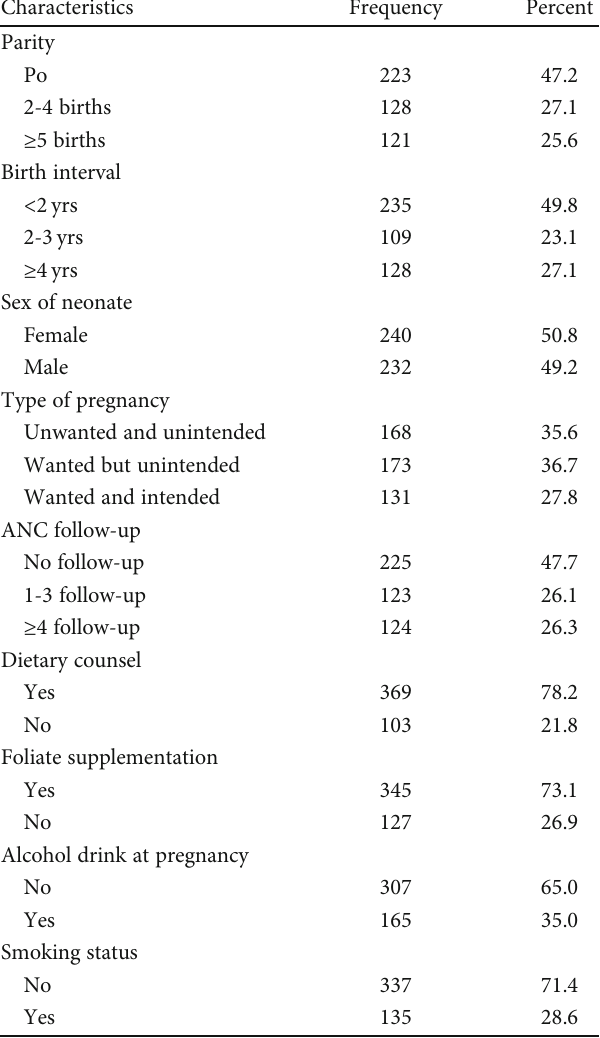
Table 2: Obstetric, nutrition-related characteristics of mothers and sex of